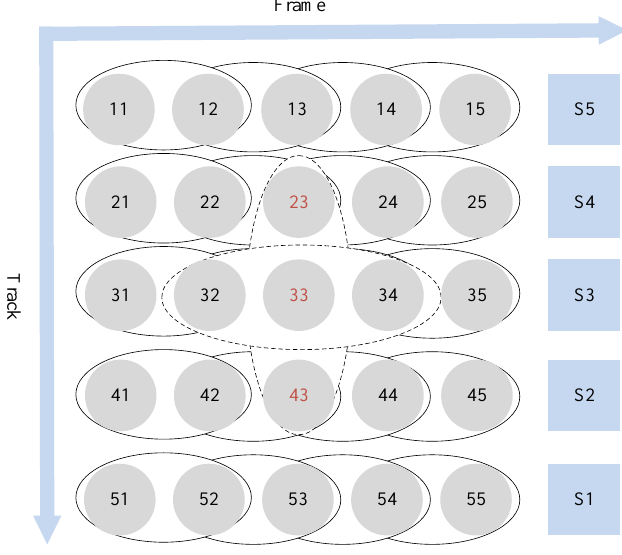
Figure 8. Hierarchical synergy